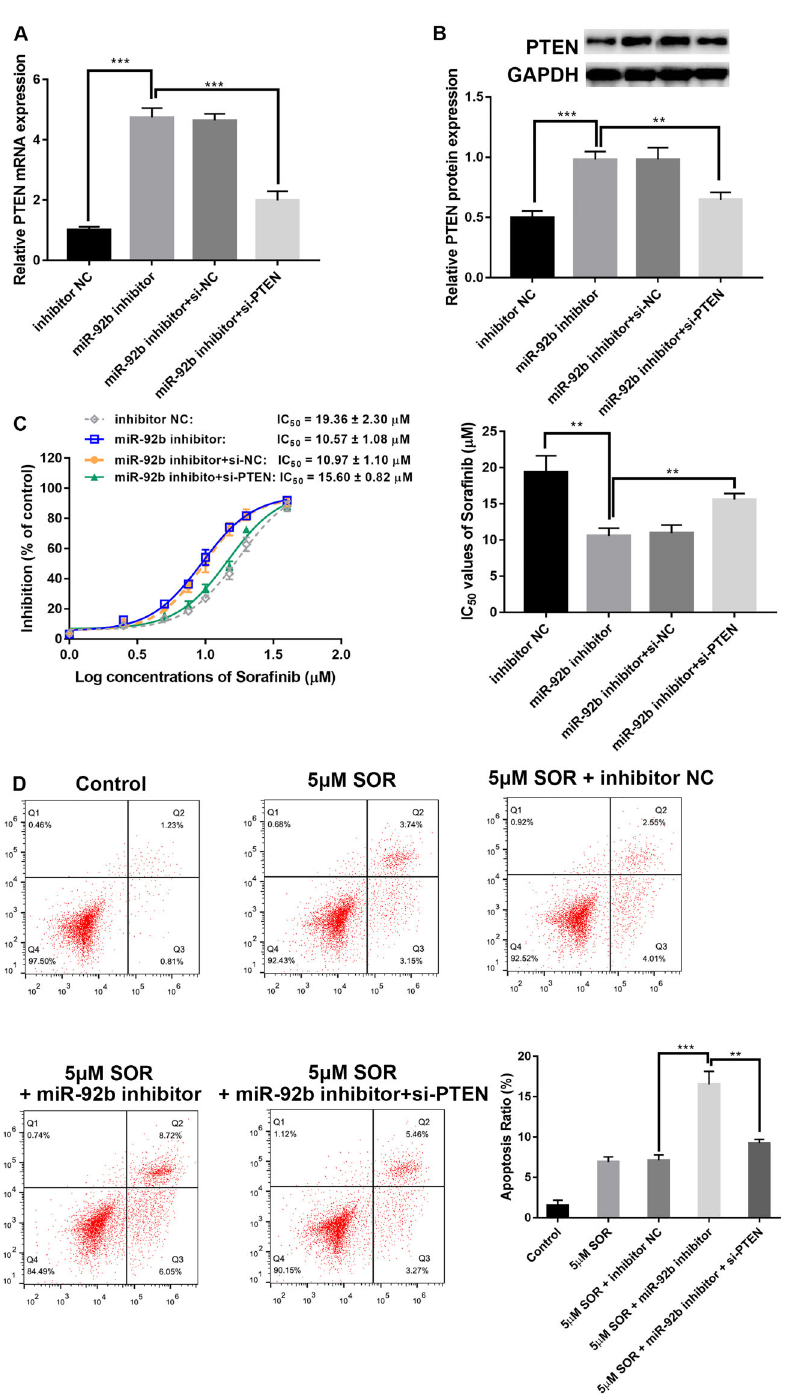
Figure 4. Knockdown of PTEN partially reversed the effect of miR-92b inhibitor in HepG2/SOR cells. A , mRNA expression and ( B ) PTEN protein expression were measured using qRT-PCR and western blot in HepG2/SOR cells at different transfections. C , Rates of inhibition and half maximal inhibitory concentration (IC 50 ) values of sorafenib in HepG2/SOR cells at different transfections. D , Flow cytometry was performed to con fi rm the effect of PTEN on apoptosis of miR-92b-downregulated HepG2/SOR cells under sorafenib treatment. Data are reported as means ± SD. **P o 0.01, ***P o 0.001 (ANOVA). NC: negative